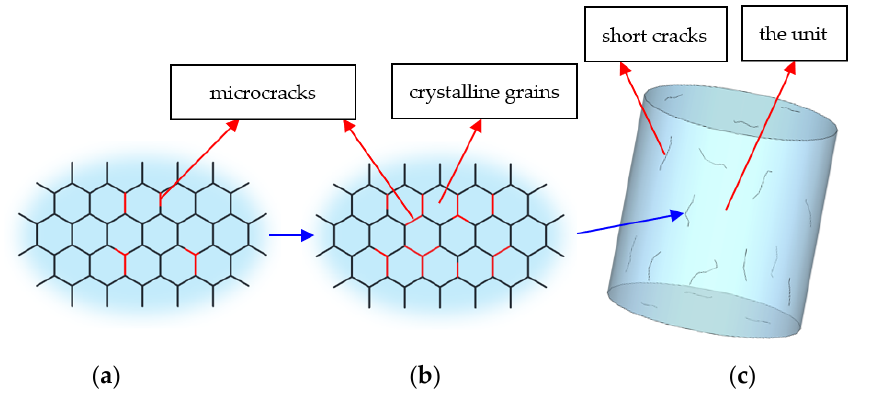
Figure 3. Short crack propagation in the representative unit. ( a ) Microcrack length at time t ; ( b ) Mi- crocrack length at t + ∆ t ; ( c ) short cracks in the